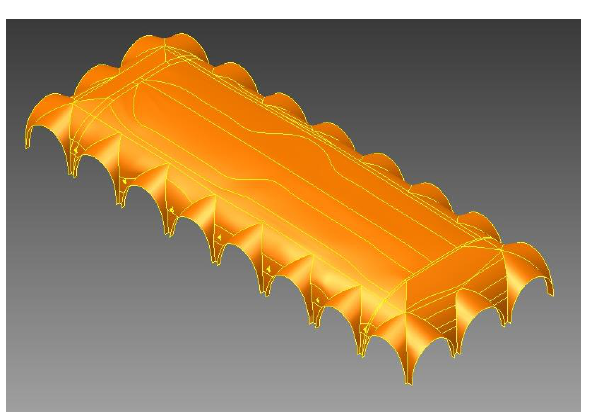
Figure 10. The FEM model of the